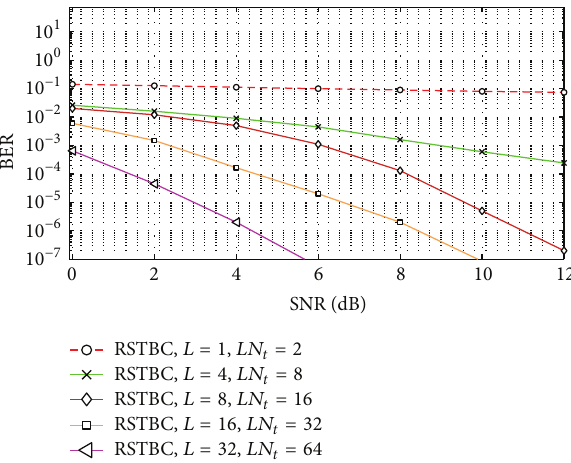
Figure 8: Spectral efficiency of RSTBC for massive SU-MIMO up to 𝐿𝑁 𝑡 = 64 with 16-QAM for 25%-loss rate.